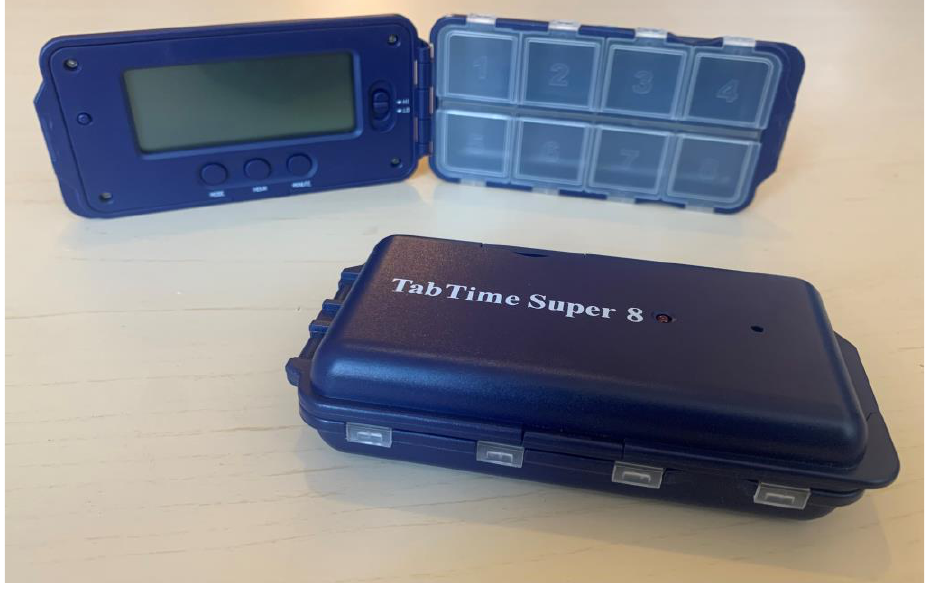
Figure 1. TABTIME ® Super